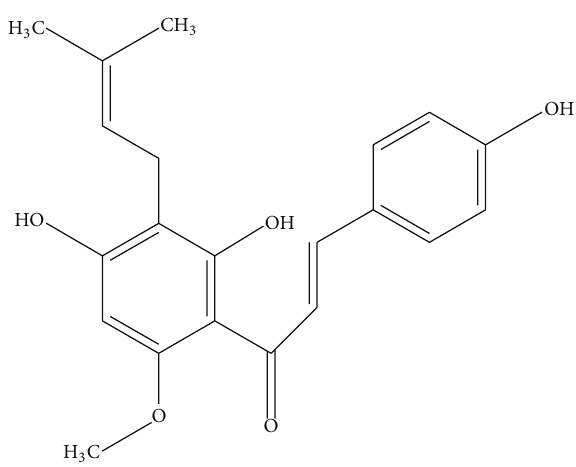
Figure 1: The molecular structure of